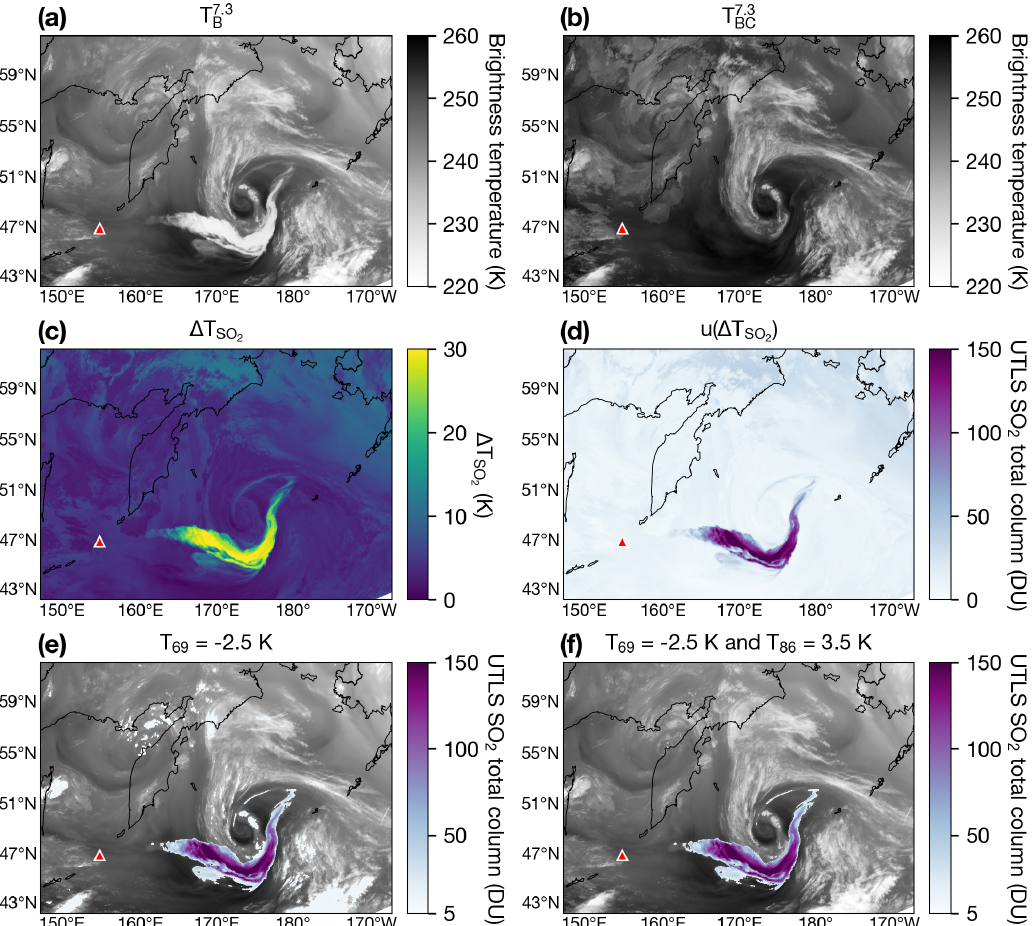
Figure B2. Volcanic SO 2 detection scheme applied to Himawari-8 observations of the Raikoke SO 2 cloud on 22 June 2019 at 21:00UTC. The location of the Raikoke volcano is indicated by a red triangle on each map. (a) Himawari-8 brightness temperature at 7.3µm ( T 7 . 3 (b) Synthetic 7.3µm brightness temperature ( T 7 . 3 ) determined from interpolation procedure (see Appendix B for details). (c) SO 2 BTD BC = T 7 . 3 − T 7 . 3 ( (cid:49)T SO ). (d) SO 2 total column loading, u((cid:49) SO 2 ) (see Appendix B for details). (e) u((cid:49) SO 2 ) with T 69 = − 2 . 5K and 5DU B BC 2 thresholds. (f) u((cid:49) SO 2 ) with T 69 = − 2 . 5K, T 86 = 3 . 5K and 5DU